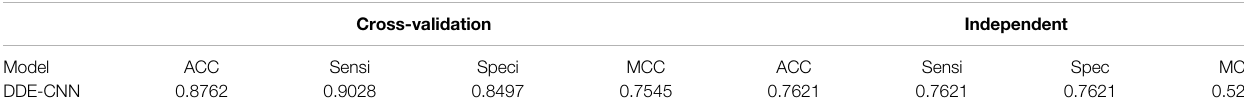
TABLE 4 | CNN identi fi cation of the optimal parameter for various